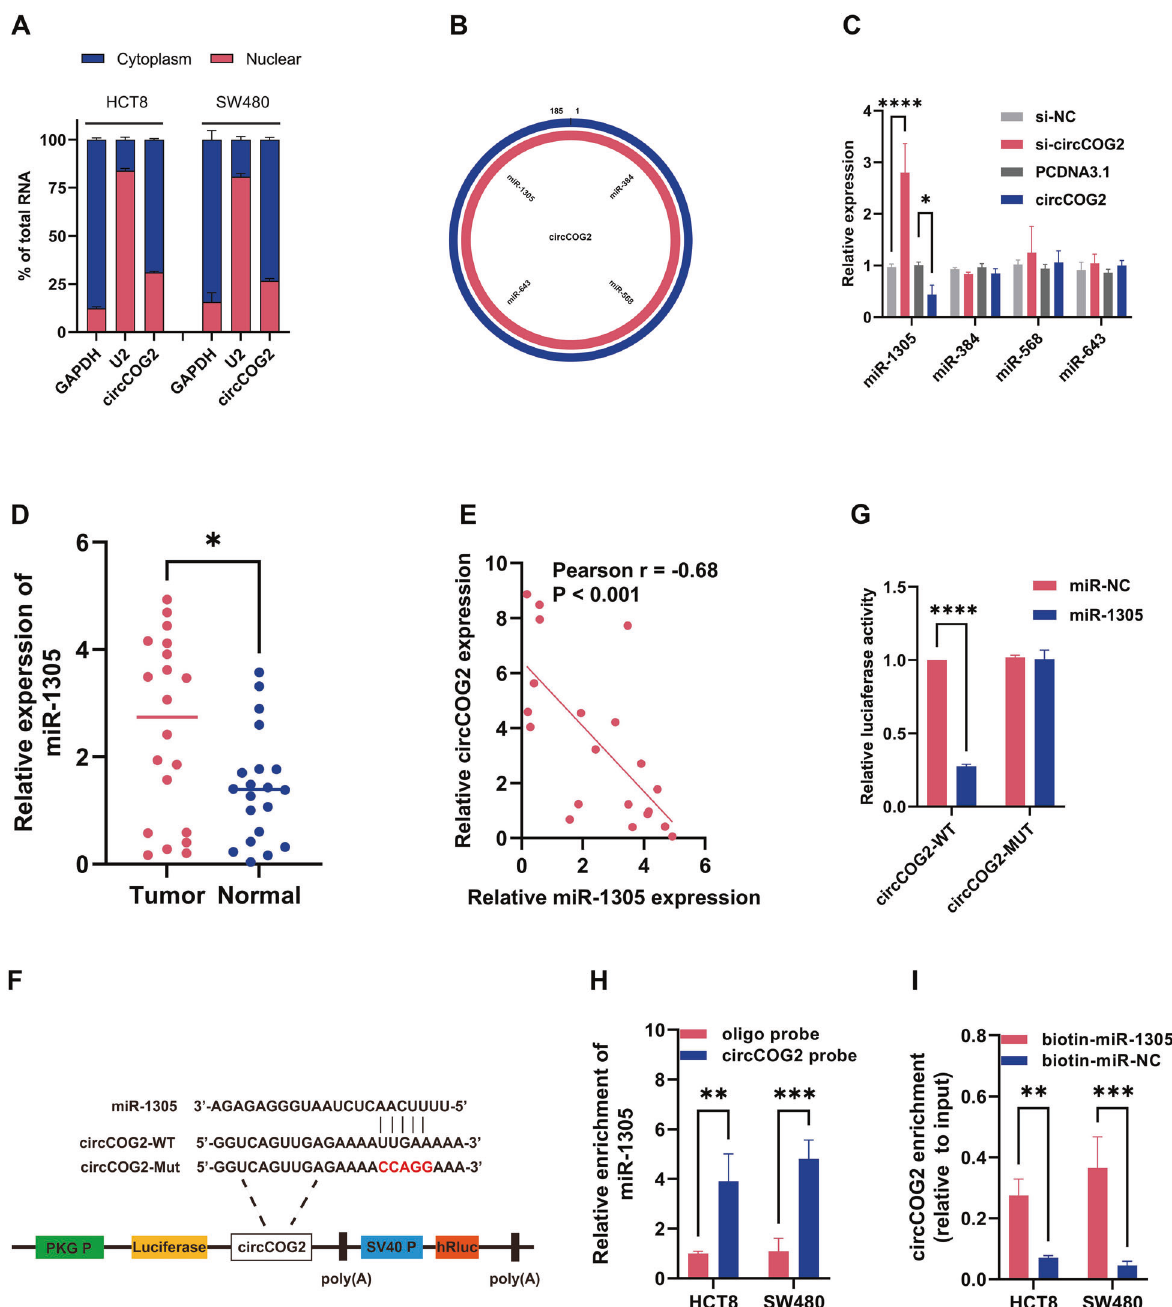
Fig. 3 miR-1305 is the target of circCOG2. A Cytoplasm and nuclear fractions indicated that circCOG2 was located in the cytoplasm. B The illustration showed the binding site of four miRNAs with circCOG2. C The expression of four miRNAs in circCOG2 knockdown or overexpression cells. D The expression of miR-1305 in CRC and normal tissues. E The expression of miR-1305 was negatively correlated with the expression of circCOG2. F The illustration of the dual-luciferase reporter plasmid. G The luciferase activity of circCOG2-WT or